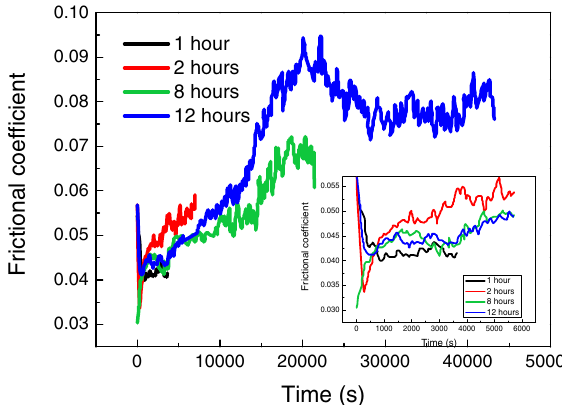
Fig. 12 The friction coef fi cient of PEEK/articular cartilage with dif- ferent friction times